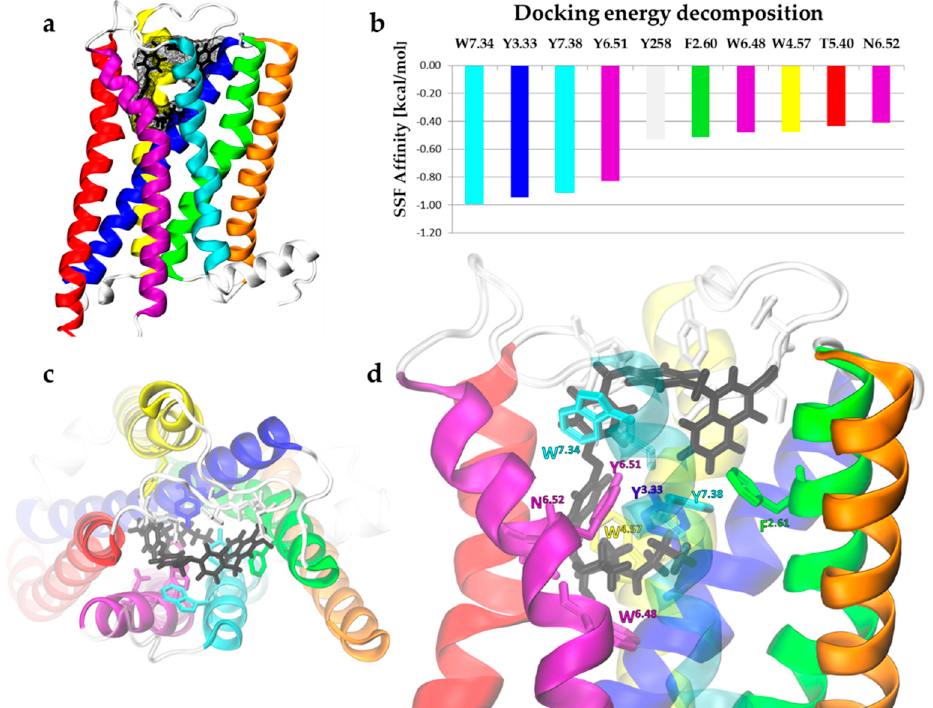
Figure 8. Molecular docking of bitopic ligand BQCA-azo-IR3535 to the homology model of Drosophila melanogaster mAChR-A. ( a ) Receptor structure with the ligand-bound (black licorice and surface representation). Note that intracellular loop 2 was removed from the model. ( b ) Docking energy decomposition shows residues giving the highest contribution to the affinity of ligand-binding. These residues are marked in ( d ). The top view ( c ) and the side view ( d ) of the BQCA-azo-IR3535 (black) docked to the mAChR-A.